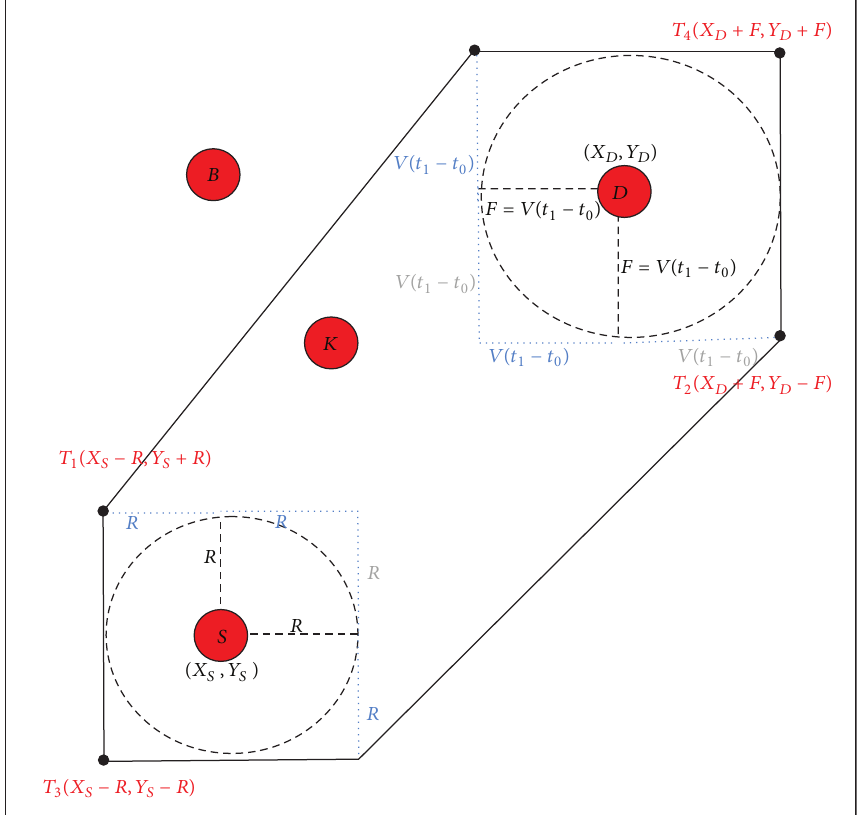
Figure 2: Proposed query